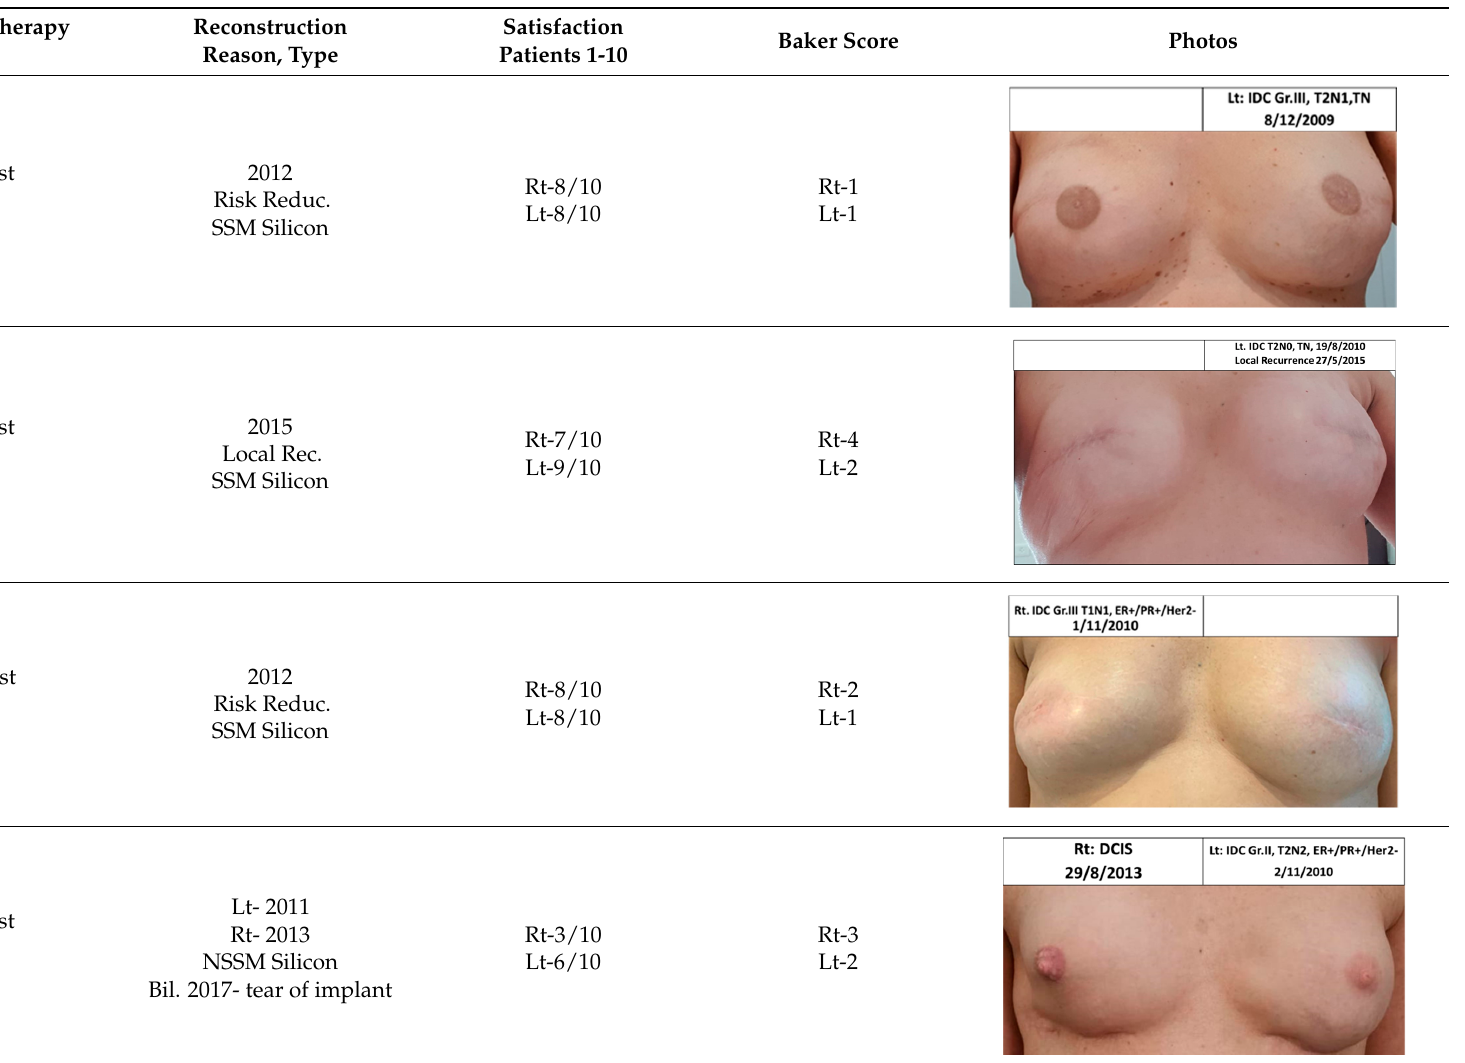
Table 2. Mastectomy and reconstruction of non-irradiated breasts.